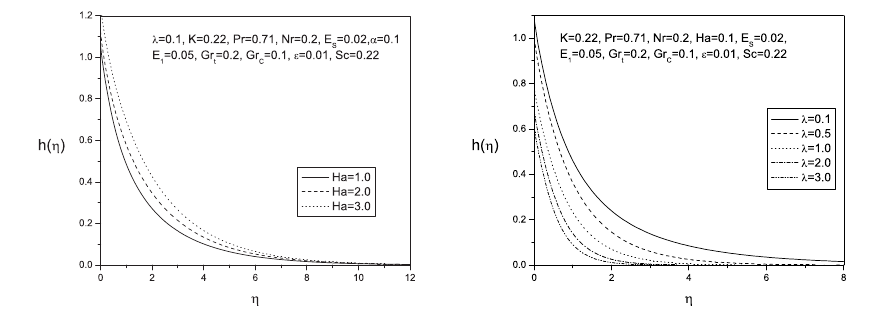
Figure 8. Variation of temperature profiles with η for different values of Ha .